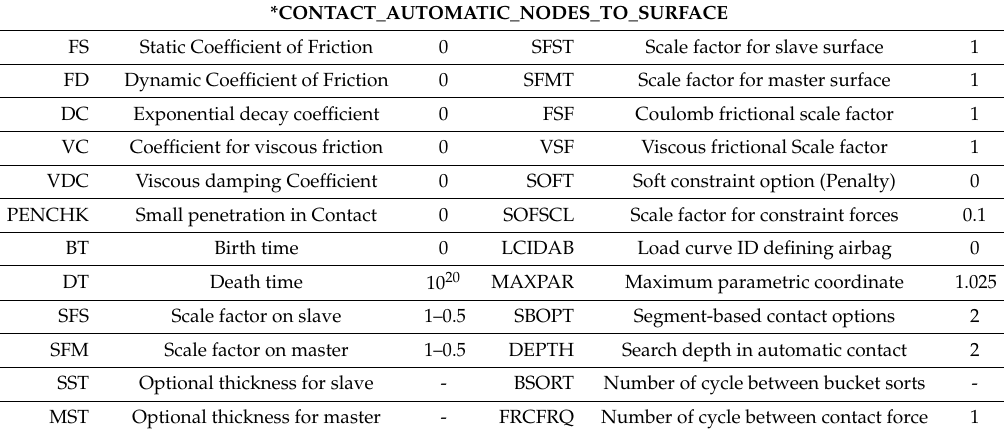
Table 1. Selected contact parameters as defined in LS-DYNA for FEM.